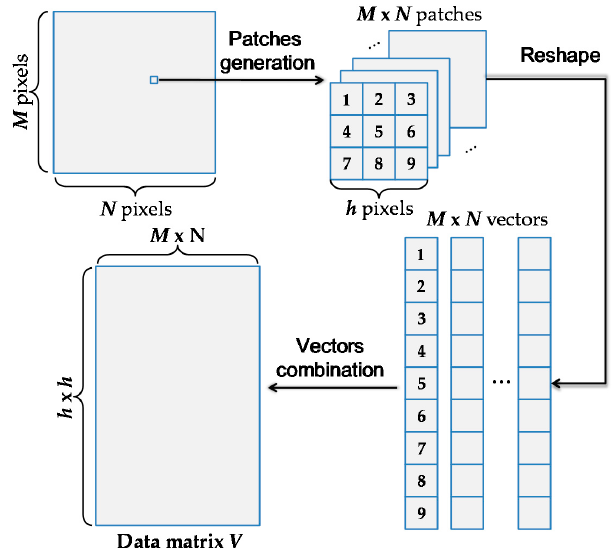
Figure 2. Flow diagram of data matrix (cid:1848) generation.